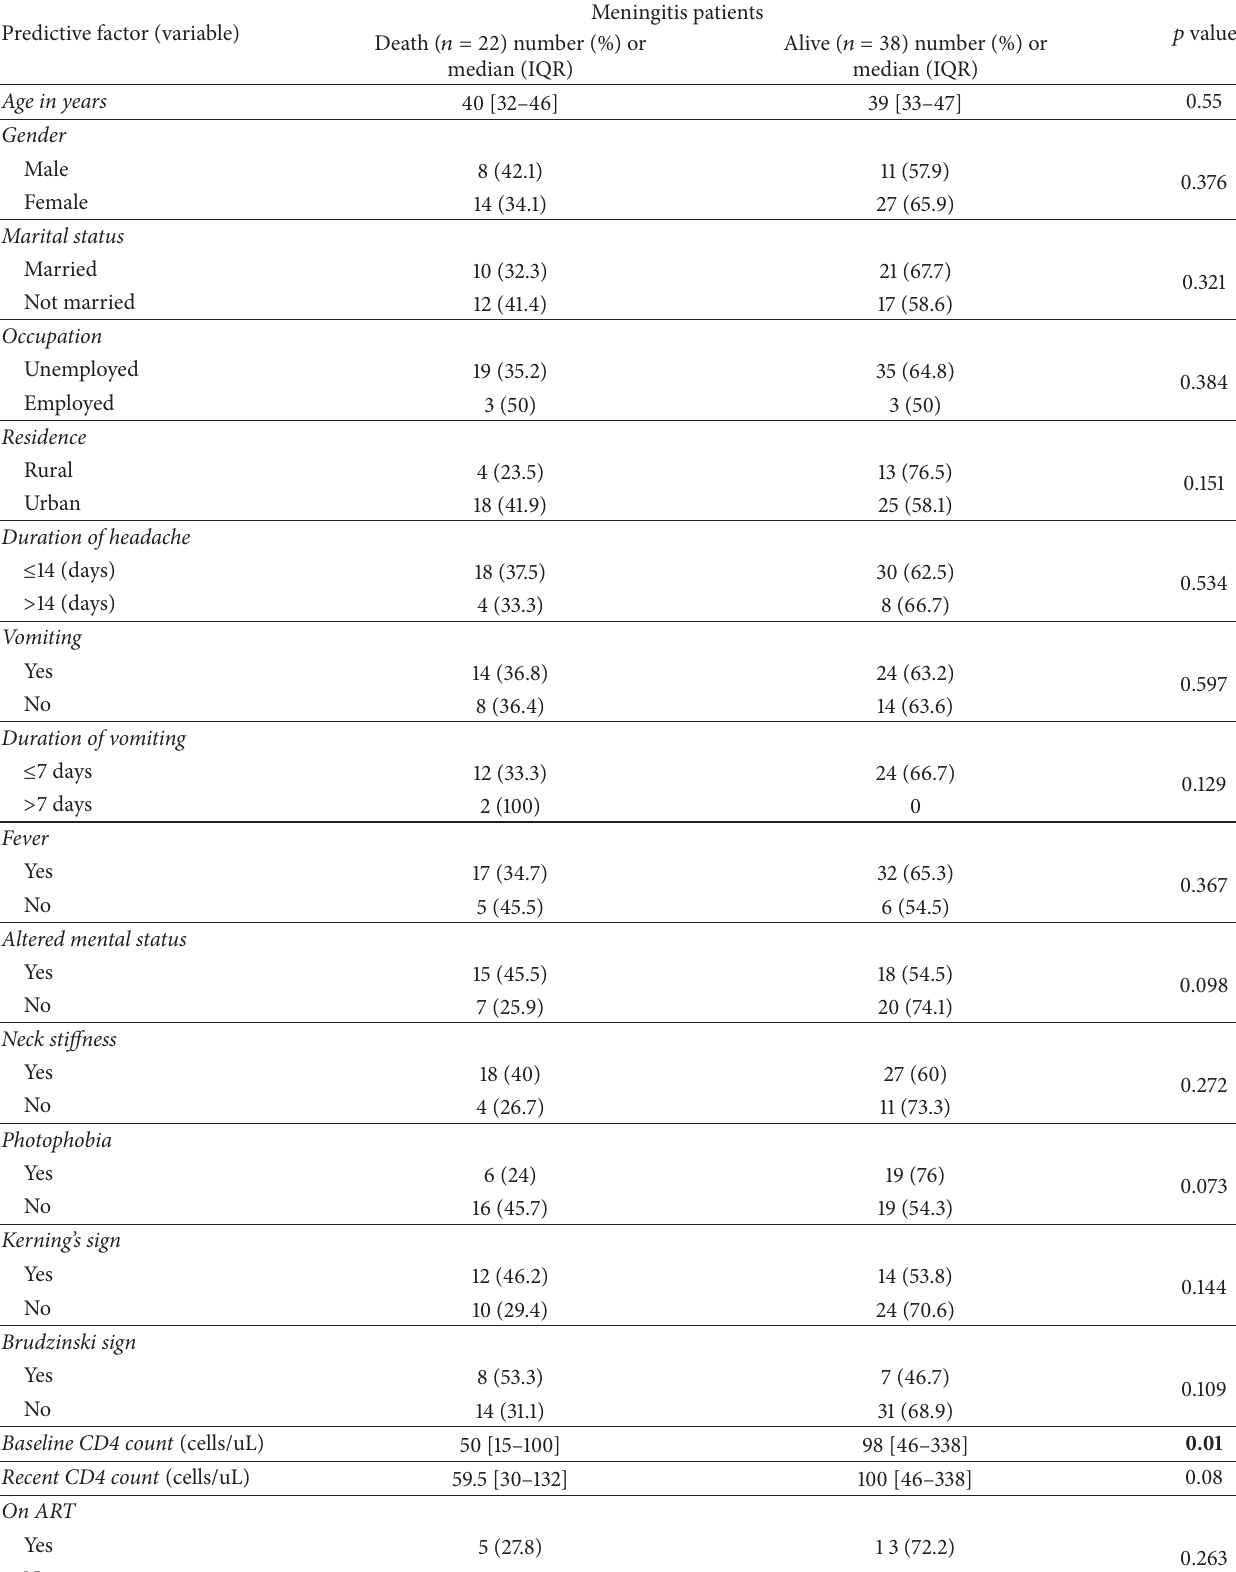
Table 3: Clinical predictors of mortality among 60 HIV-infected adults patients admitted with meningitis to medical wards of Bugando Medical Centre,